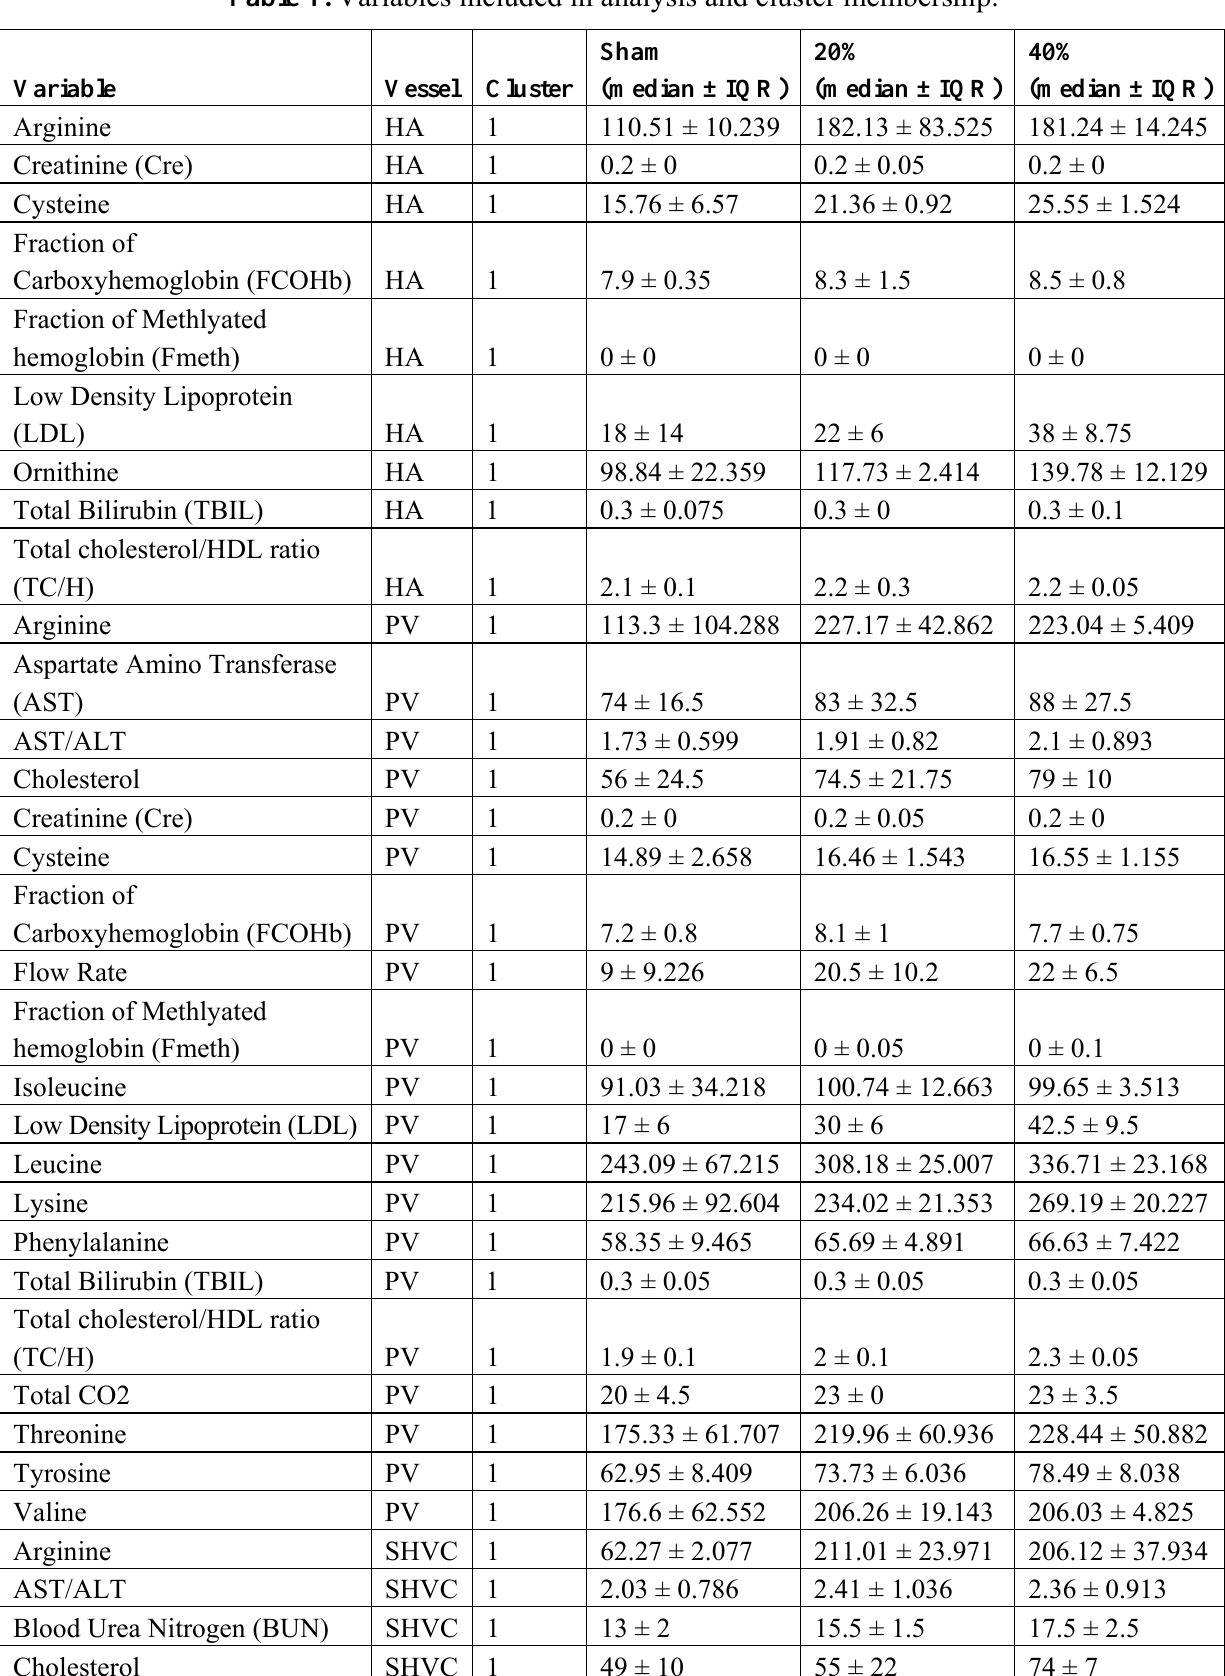
Table 1. Variables included in analysis and cluster